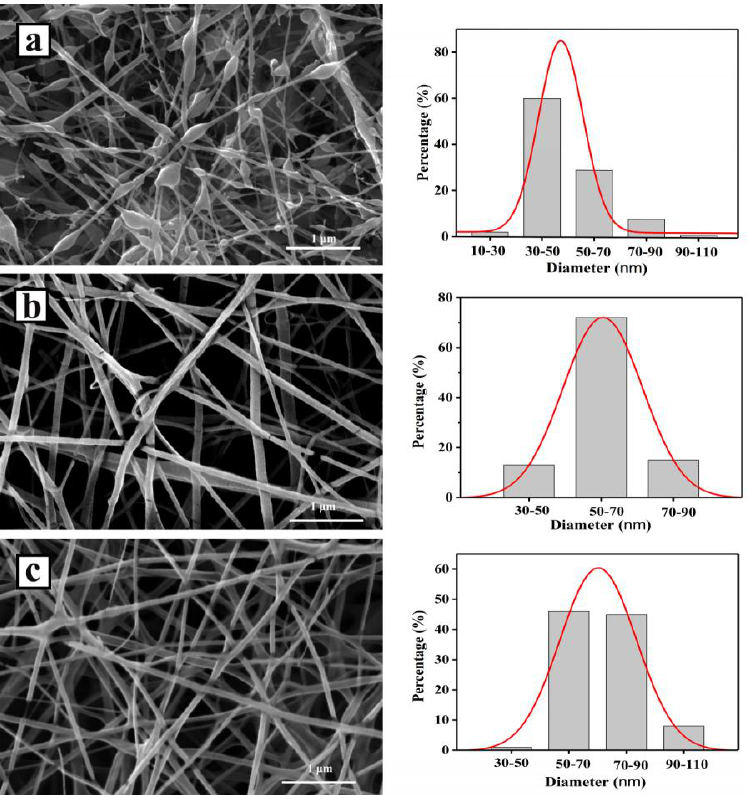
Figure 1. SEM images of electrospun ART-loaded PCL/Col nanofibers and nanofiber diameter dis- tribution histograms. ( a ) PCL/Col-A; ( b ) PCL/Col-B; ( c ) PCL/Col-C. distribution histograms. ( a ) PCL/Col-A; ( b ) PCL/Col-B; ( c )